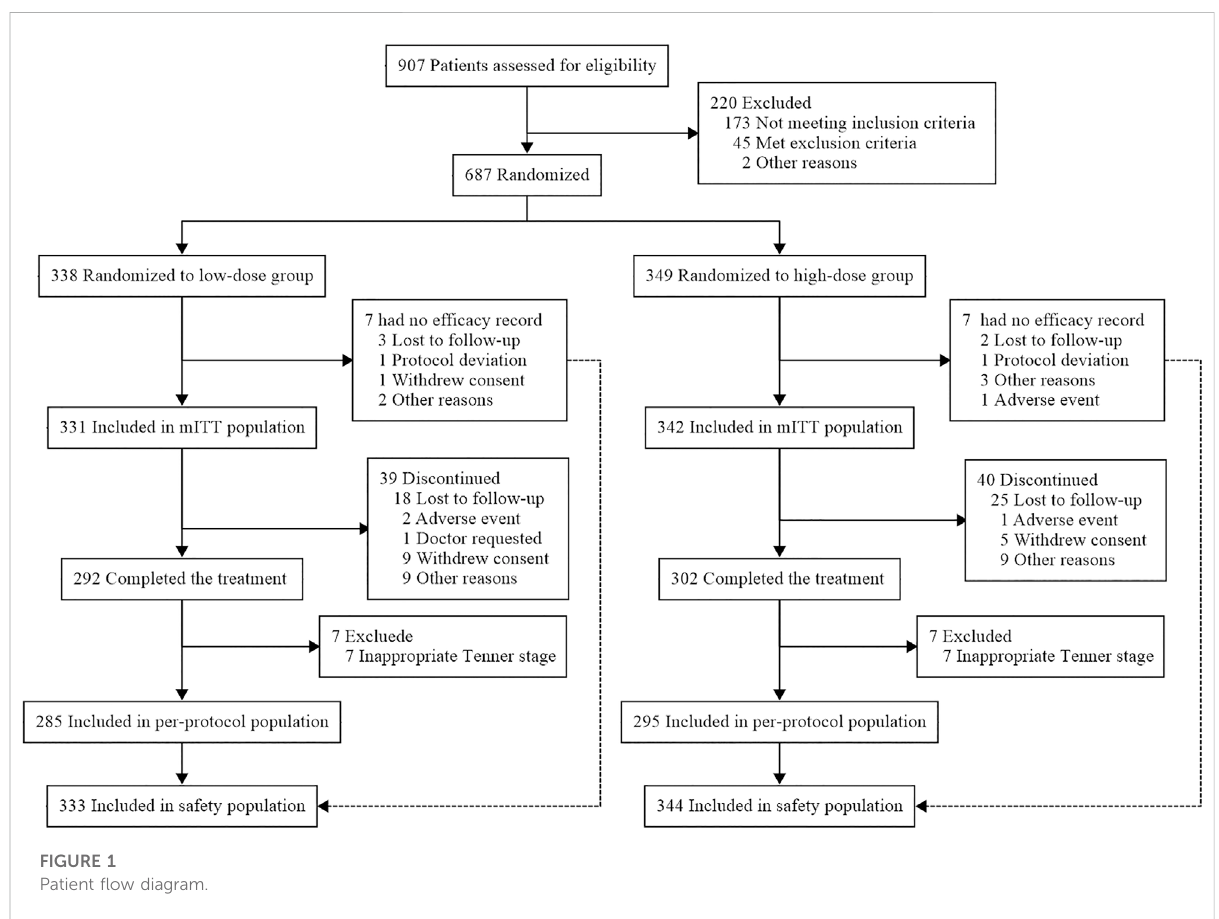
FIGURE 1 Patient fl ow